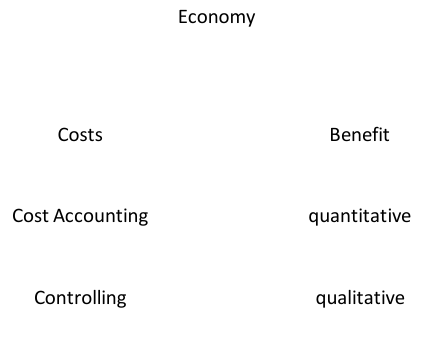
Figure 3. Structuring in line with the dimension